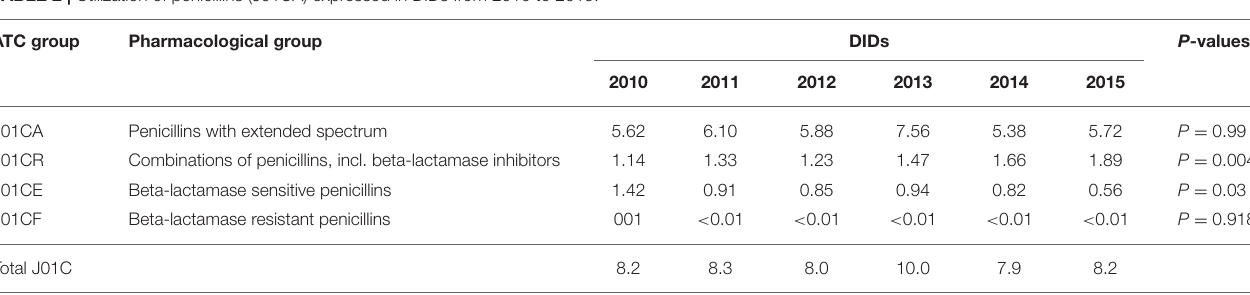
TABLE 2 | Utilization of penicillins (J01CA) expressed in DIDs from 2010 to 2015. ATC group Pharmacological group DIDs P